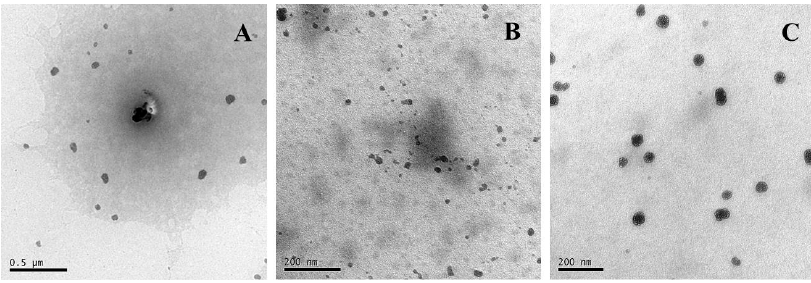
Figure 6. TEM images of NG1 ( A ); NG2 ( B ) and NG3 ( C ).